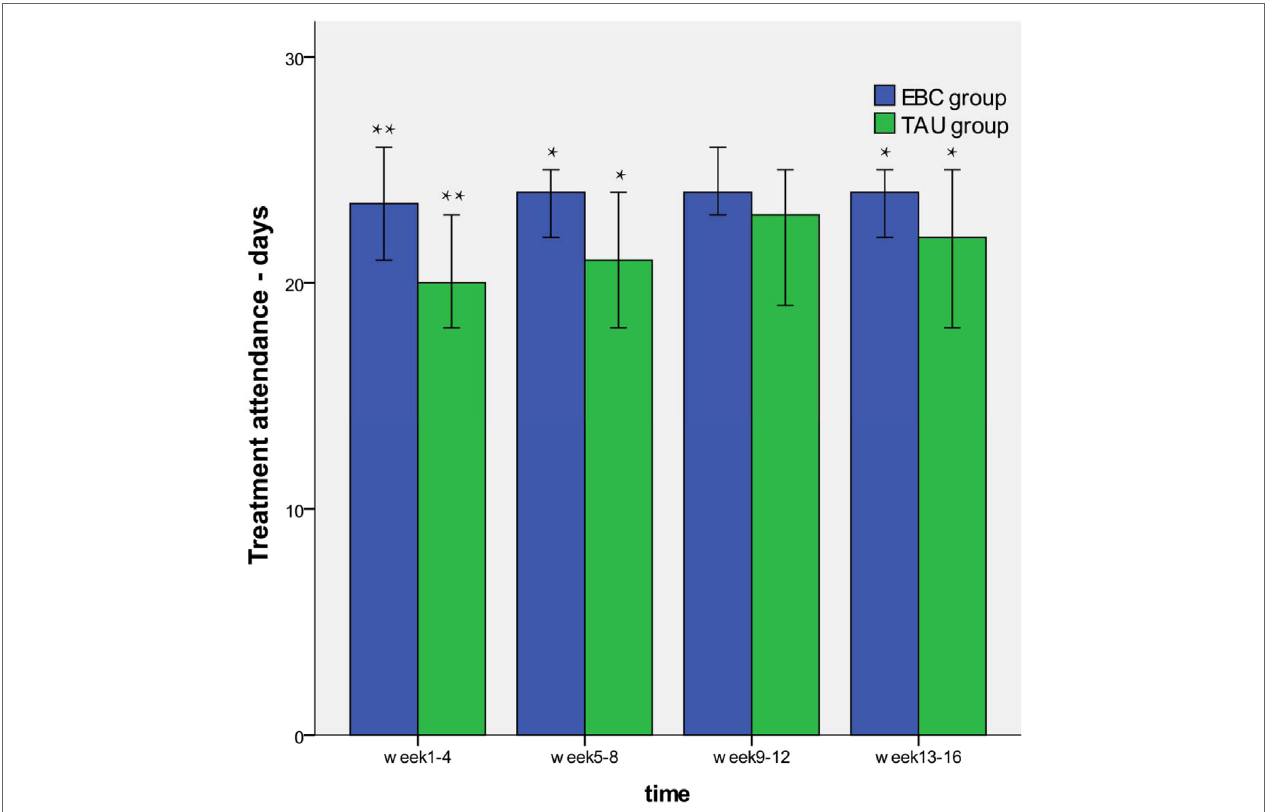
FigUrE 2 | Treatment attendance of educational and behavioral counseling (EBC) and treatment as usual (TAU) group. The patients in the EBC group showed better treatment attendance than those in TAU group. There was not significantly group different during weeks 9–12 (* P < 0.05, ** P < 0.01).